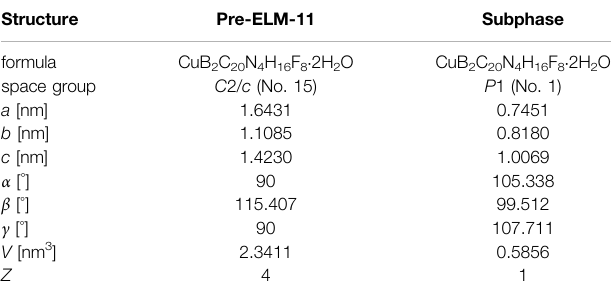
TABLE 1| Crystallographicdataforpre-ELM-11and thesubphaseobtainedfrom structural analysis. Structure